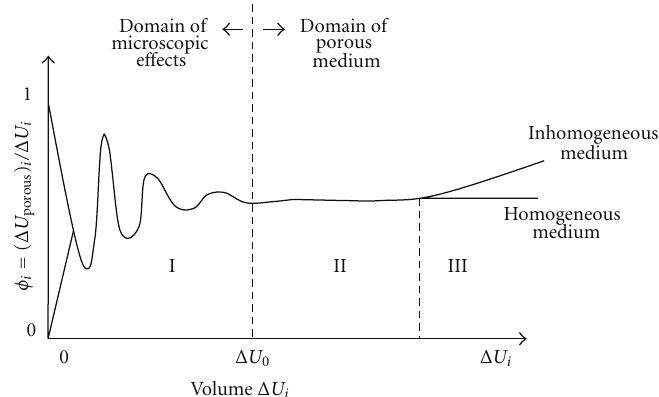
Figure 1: Representative elementary volume (REV, Δ U 0 ) for the porosity ( φ ). Δ U i represents any volume in the porous media. REA is defined from the concept of REV and shows similar behavior. Source: adapted from Bear